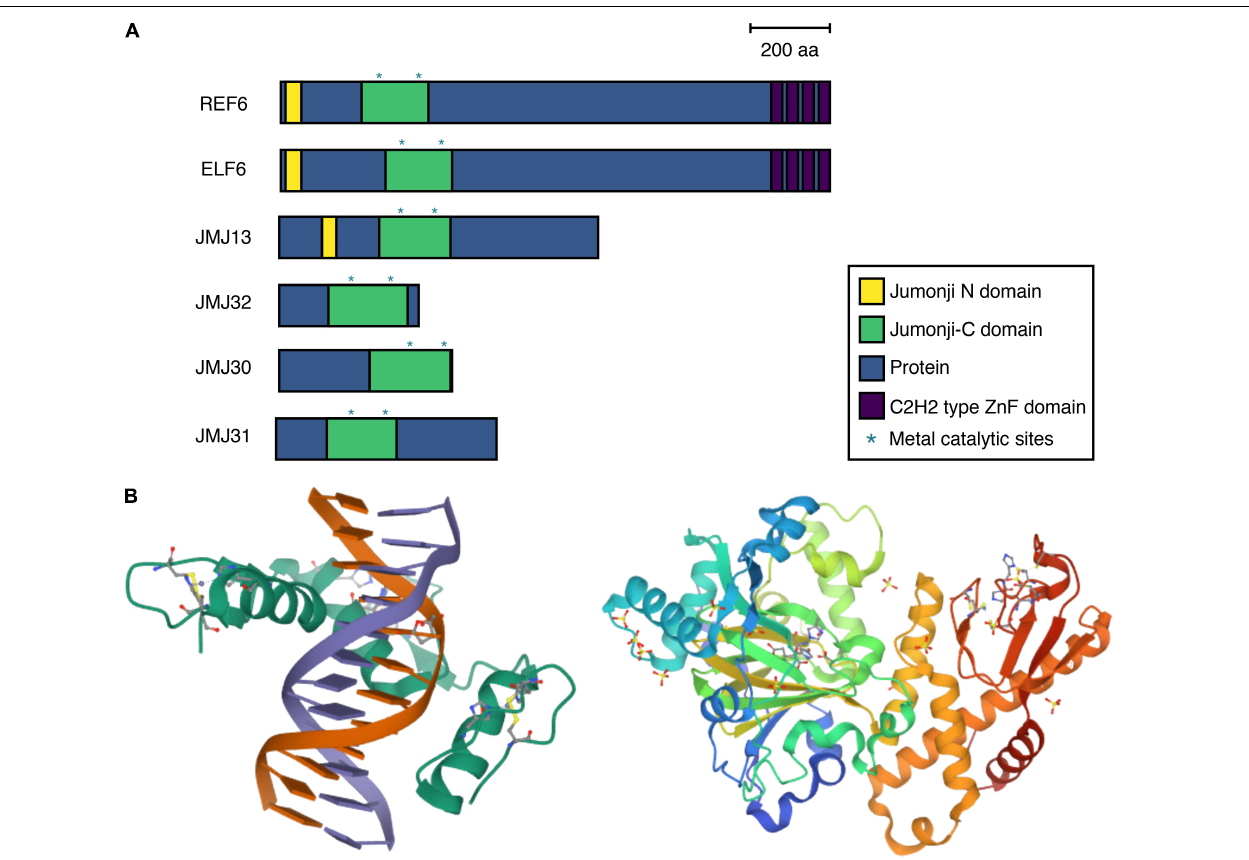
FIGURE 1 | Conserved motifs, and three-dimensional structure of H3K27me3 demethylases in Arabidopsis thaliana . (A) The domain structures of Jumonji domain–containing proteins (JMJs) in A. thaliana . The positions of the Jumonji N domain, Jumonji C domain, protein, and C2H2-type zinc-finger (ZnF) domains are indicated in yellow, green, blue, and purple, respectively; metal catalytic sites are indicated with asterisks. Scale bar = 200 amino acids. (B) Crystal structure of JMJ proteins. Left REF6 ZnF and NAC004 -mC3 double-stranded (ds) DNA. Ribbon representation of REF6-DNA structure. REF6 protein is shown in green, while dsDNA is shown in orange and purple. α -helices and β -sheets are represented by spiral ribbons and green arrows, respectively. A few residues engage Zn 2 + ion. Right The JMJ13 catalytic domain in complex with AKG. Ribbon representation of JMJ13 structure. Blue and green ribbons represent JMJ domains. Orange and red ribbons show helical and ZnF domains, respectively. The data were obtained from the Protein Data Bank (https://biorender.com).